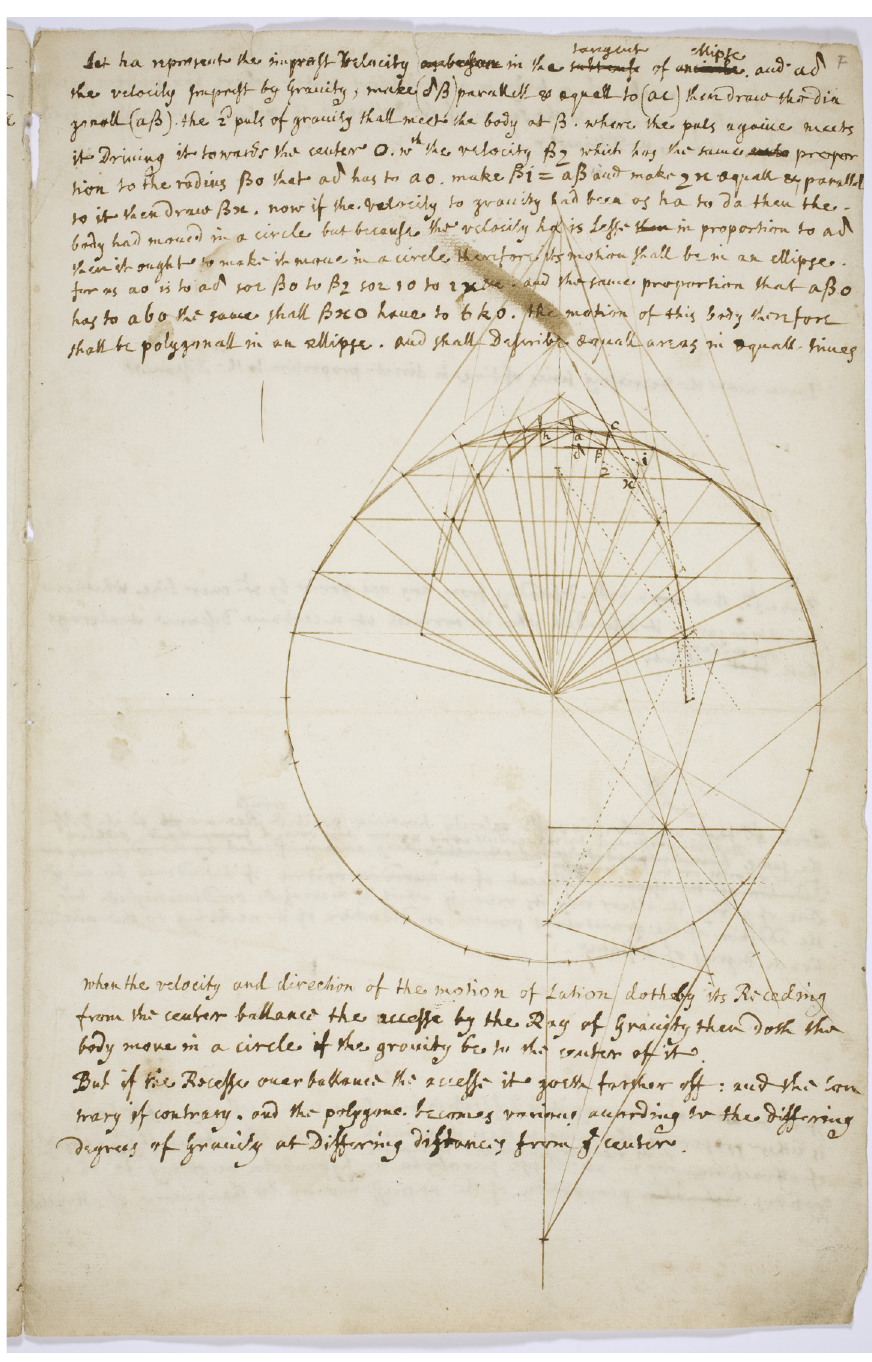
Figure 1: In September 1685, apparently after seeing Newton ’ s “ De motu corporum in gyrum ” ( the embryonic manuscript that gave rise to the Principia ) , Hooke wrote a manuscript on central force motion that graphically implements his 1674 hypothesis on planetary motions.Here Hookeconstructs apolygonal approximation to the ellipticaltrajectorytraced by abodyattractedbya centralforcewhose intensity is proportional to distance ( Hooke ’ s law ) . His technique, probably derived from the fi rst theorem of Newton ’ s “ De motu ” ( MS Add. 3965.7, fols 55r - 62bisr, Cambridge Univesrity Library ) , consists in compounding tangential inertial motion with displacements directed towards the center and whose length is proportional to the force ’ s intensity. The impulsive force ( the “ puls of gravity ” ) is assumed to act at instants separated by equal intervals of time. This manuscript is discussed in Pugliese, “ Robert Hooke and the Dynamics of Motion ” and Nauenberg, “ Robert Hooke ’ s Seminal Contribution. ” Source: Trinity College, Cambridge. MS O.lla.116. By courtesy of the Master and Fellows of Trinity College ( Cambridge )